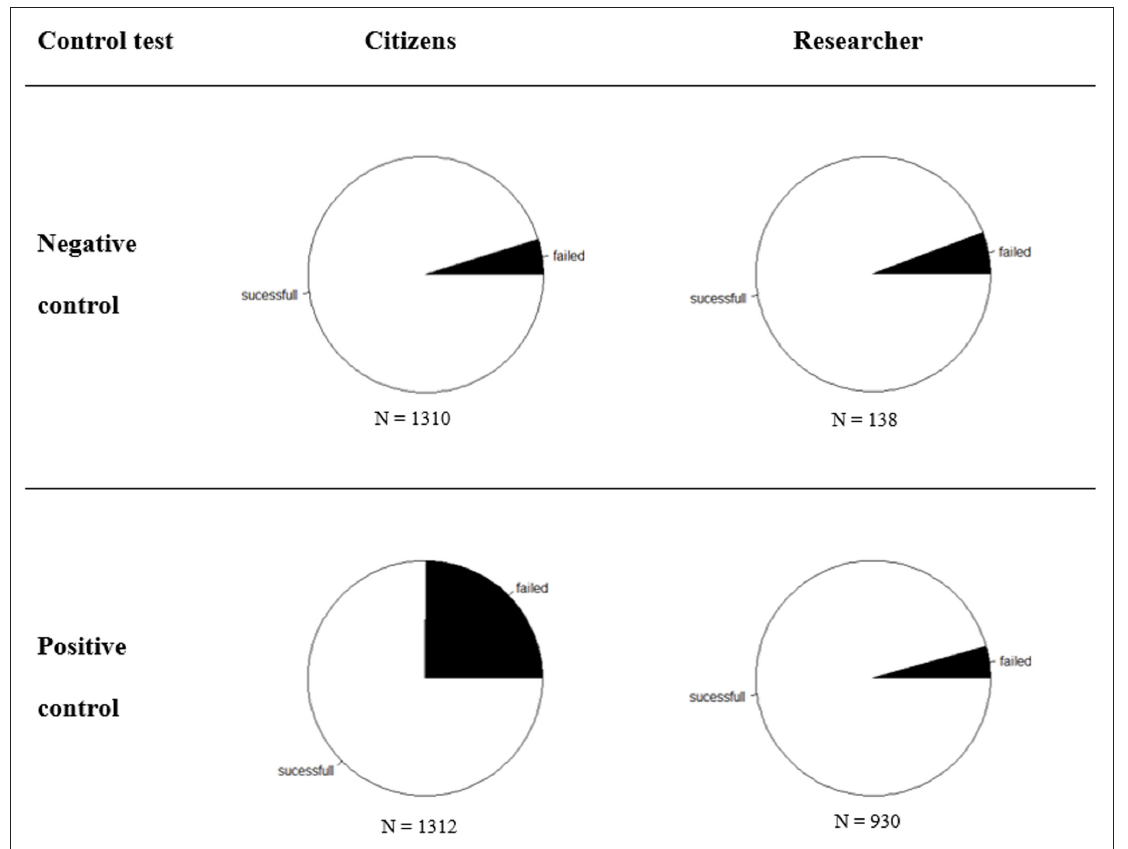
Figure 6 Share of failed and successful control tests for the researcher and citizens pooled across the 14 species assays included in the comparison. See Table 1 for statistical